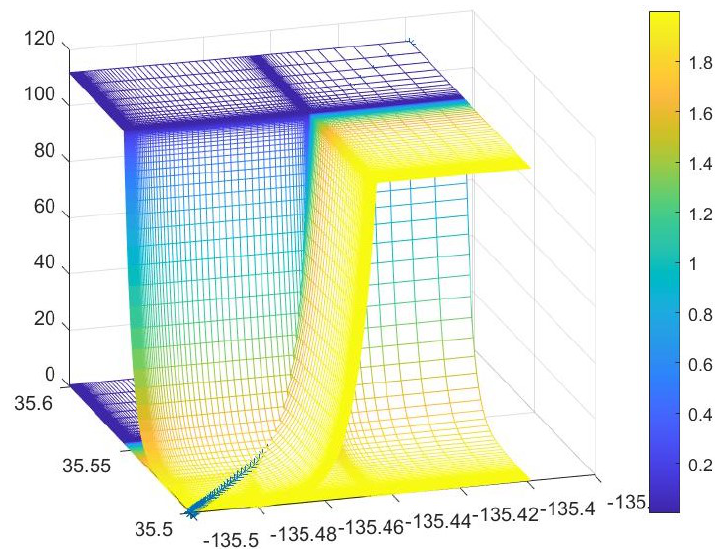
Figure 10. Result under theoretical test.